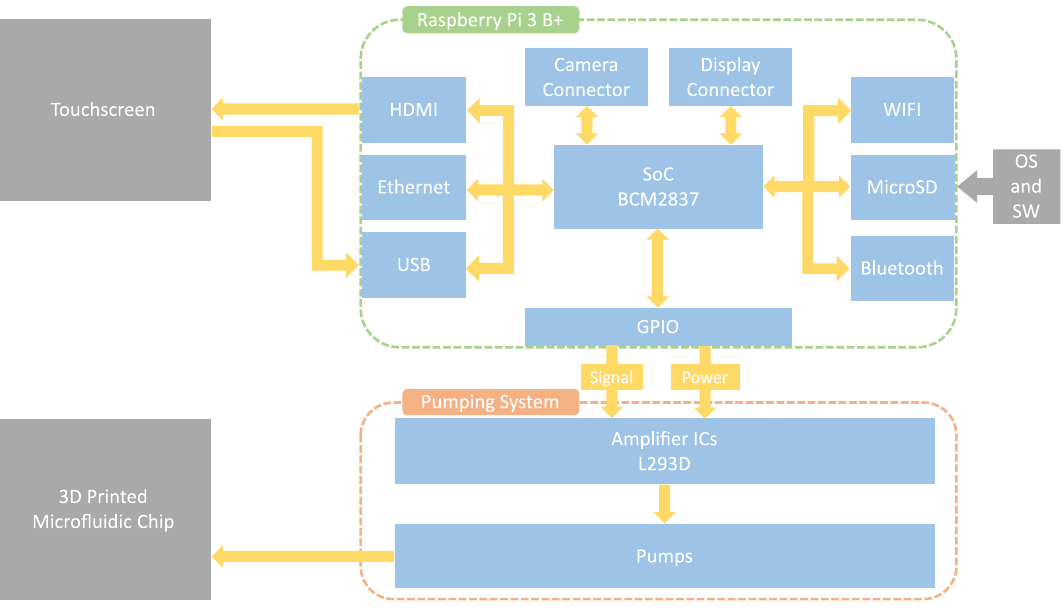
Figure 1. Block diagram of the system. The system consists of a touchscreen, a single board computer with MicroSD card as mass storage, and a pumping system capable of generating controllable positive and negative pressure output. The system can, for example, directly control a 3D-printed microfluidic